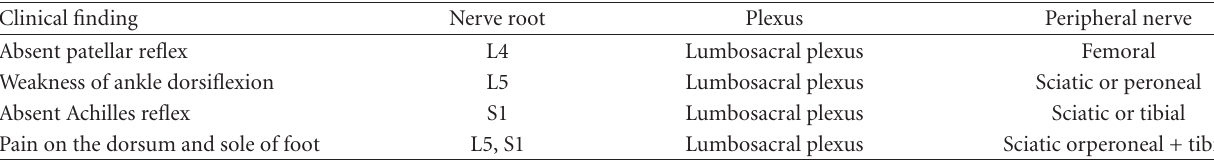
Table 1: Clinical findings and anatomic